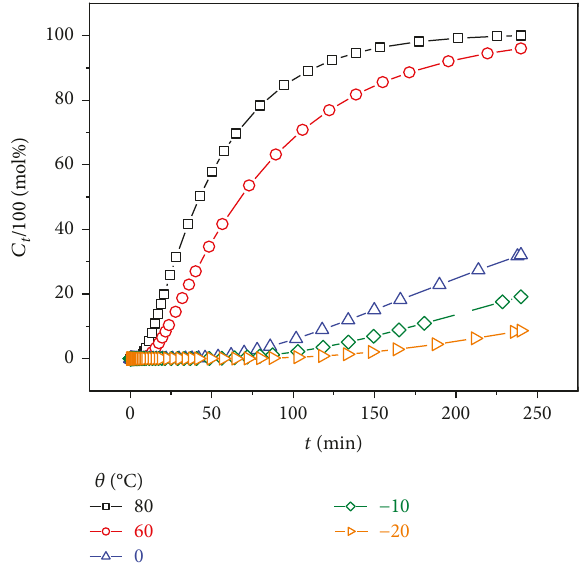
Figure 3: Simulation results for the temporal development of the changes in concentration of acetone in the middle of Estane samples with rectangular shapes (W × H × L: 2 × 10 × 50mm 3 ) at di ff erent